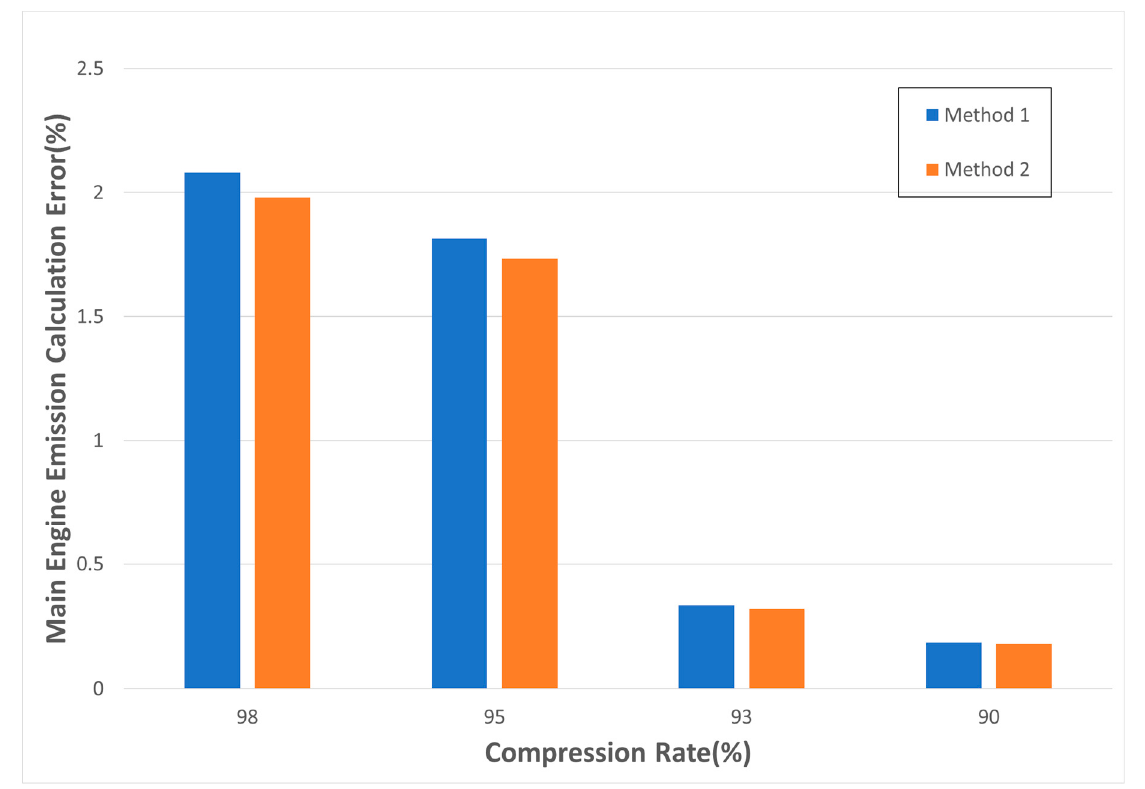
Figure 3. Emission calculation errors of two thresholds σ and σ ’ using methods at the same compres- E sion rate. Method 1 uses the threshold considering the acceleration rate of change, and Method 2 uses the threshold considering the standard error of emissions calculation. The emission calculation errors of the two threshold setting methods at the same compression rate are close, which also proves the reasonableness of the threshold design of the proposed